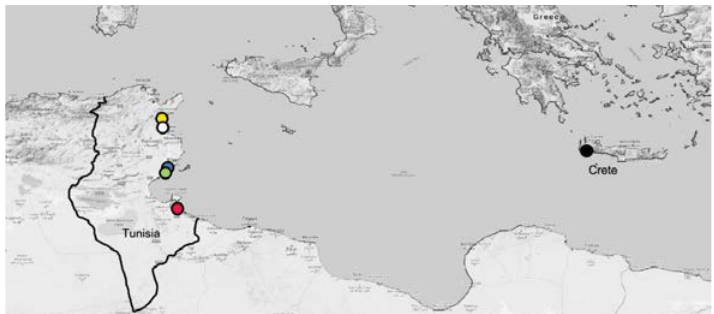
Figure 1. Main sampling regions of Tunisian and Greek Prays oleae utilized in this study. Red = Zazis, green = Chaffar, blue = Hajeb, white = Sidi Bouali, yellow = Bouficha and black = Crete.